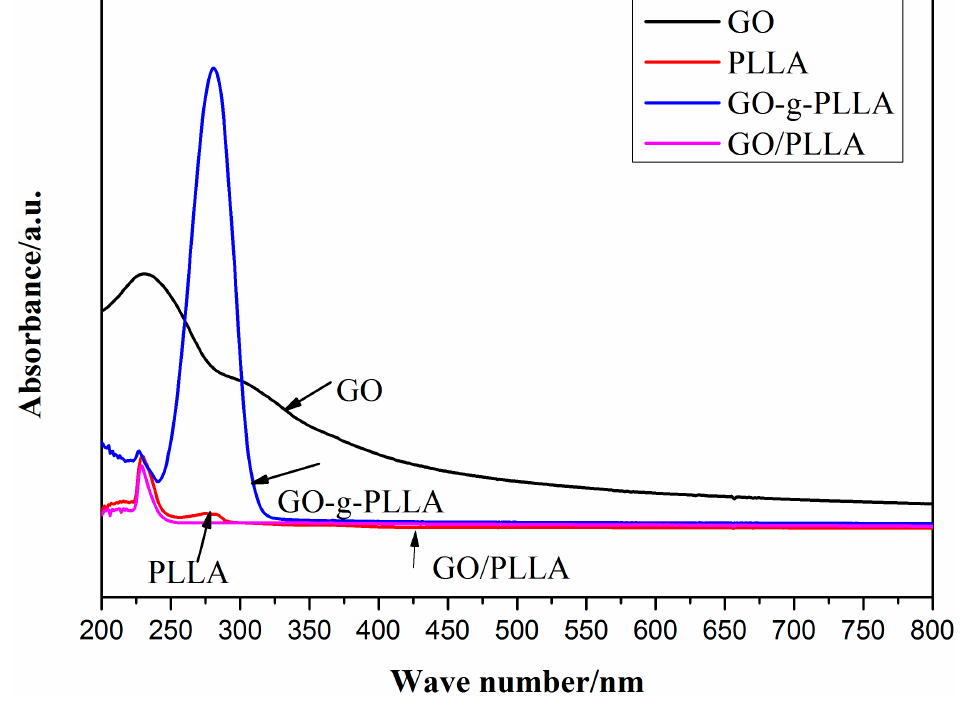
Figure 3. UV/Vis spectra of GO , PLLA, GO- g -PLLA, and GO/PLLA.